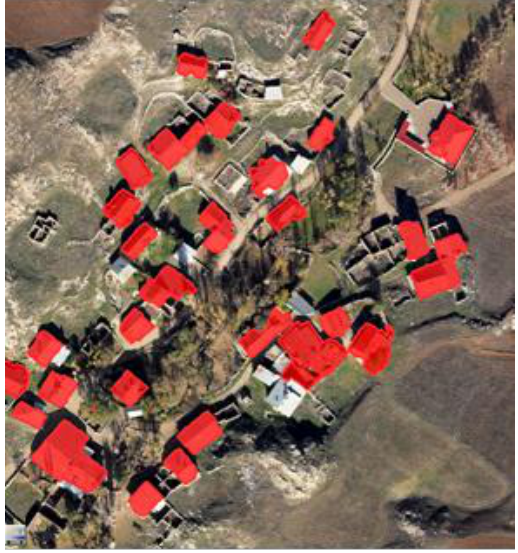
Figure 5. The extracted building